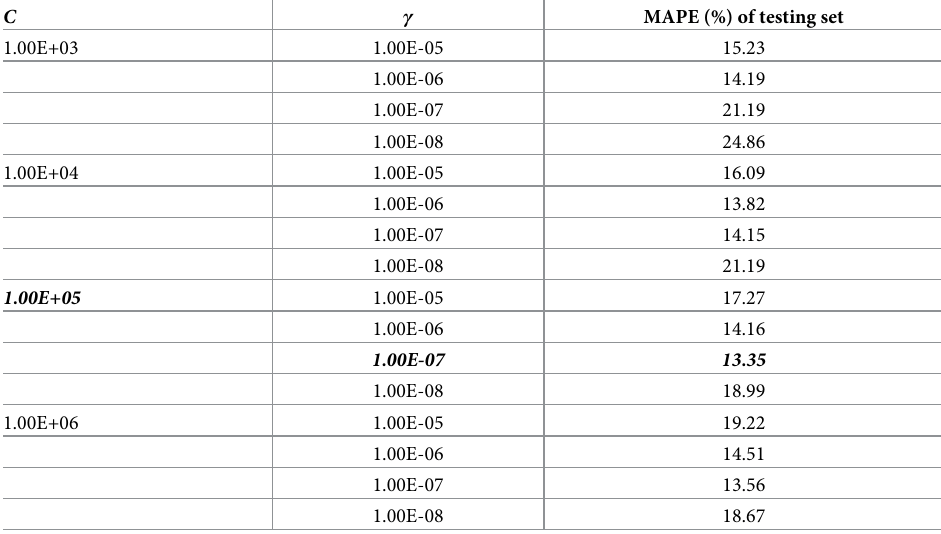
Table 3. MAPEs of the proposed hybrid model forecasting using different SVM